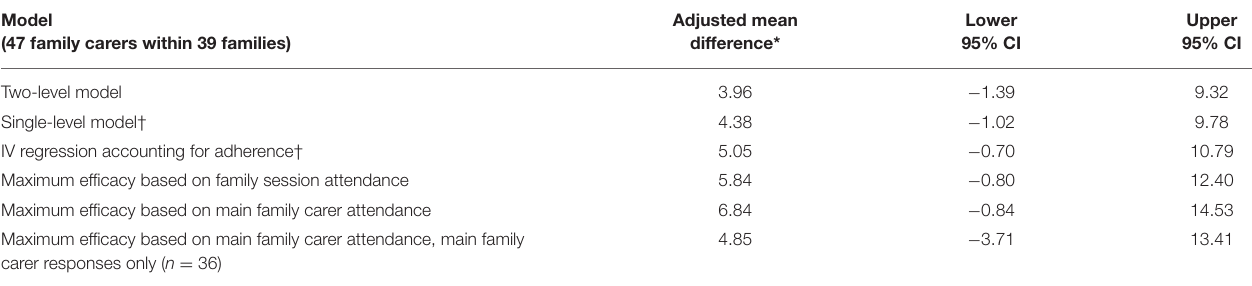
TABLE 5 | Between-arm differences on WEMWBS at 12-months post-randomisation with and without accounting for adherence or attendance. Model (47 family carers within 39